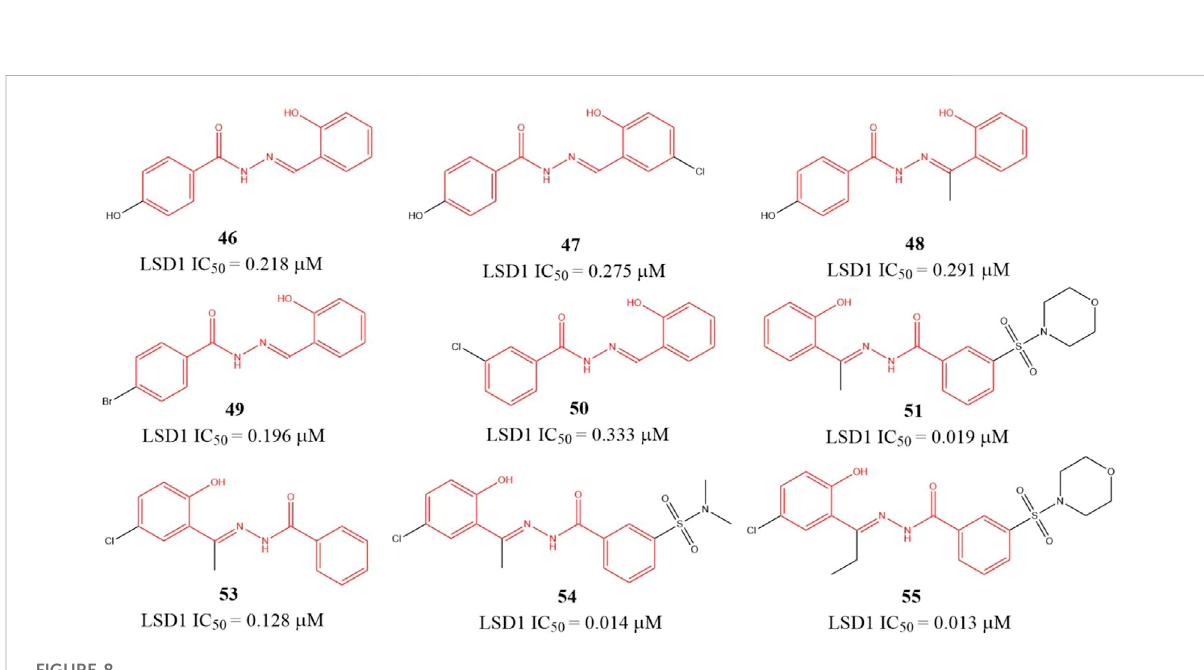
FIGURE 8 Structure of benzohydrazide-based LSD1